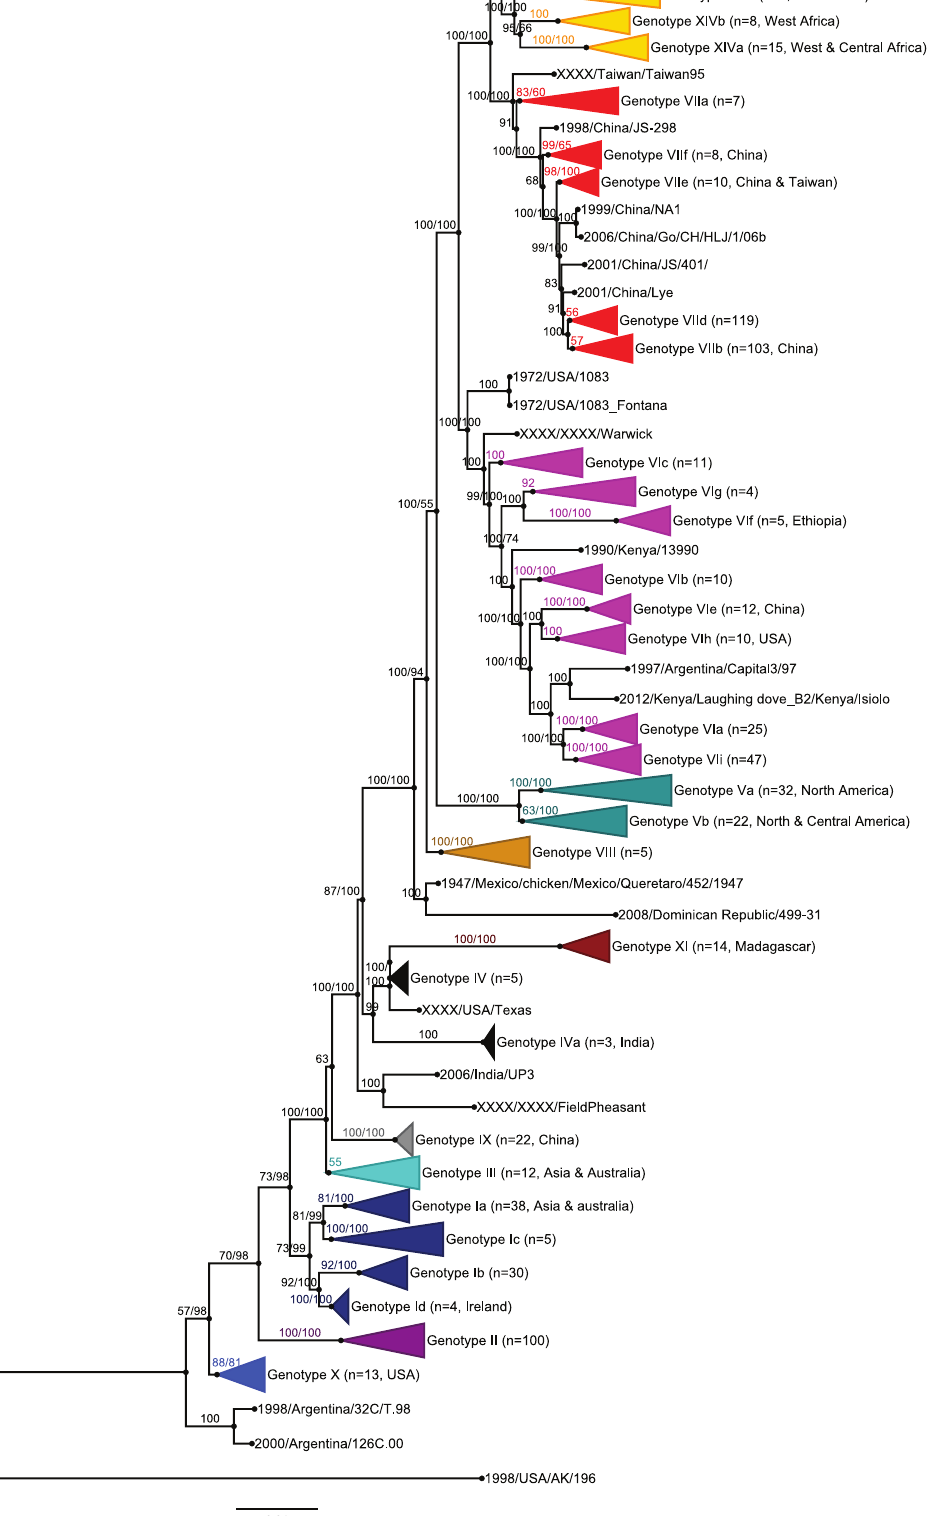
Figure 1. Phylogenetic analysis of 741 complete F nucleic acid sequences of NDV. Trees were constructed using Bayesian inference with 16,806,000 iterations and 1/1000 tree sampled in the chain. Minimal average ESS for all parameters was 1681, and PSRF were between 0.99996 and